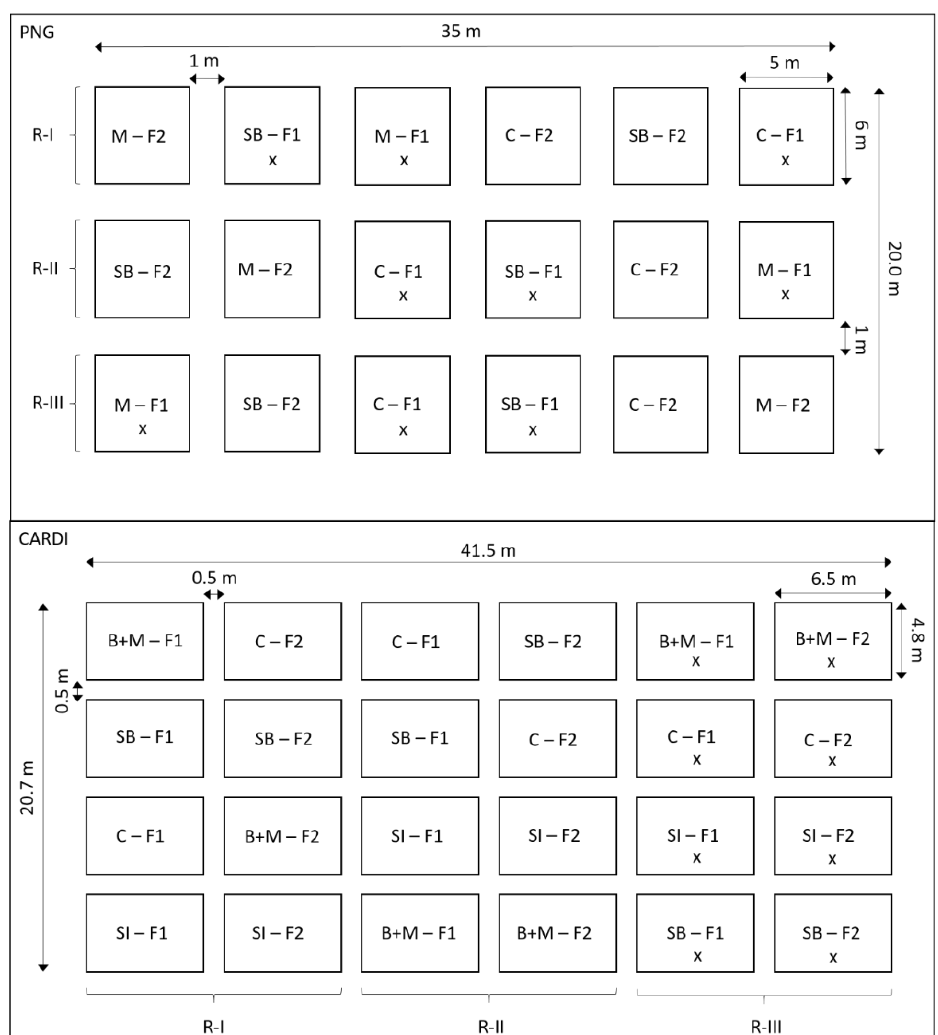
Figure 2. Experimental layout during the 2016/17 dry season of experiment 1 at PNG ( top ) and experiment 2 at CARDI ( bottom ). Location of the soil water tension sensors in each experiment is indicated with the symbol “x”. C = control; SB = rice straw buried; M = manure; B + M = biochar plus manure; SI = rice straw incorporated. F1 and F2 in the experiment at PNG indicate fertilizer placed in the middle of the bed and along the edge of the bed, respectively. At CARDI, F2 plots were fertilized with 1.5 times the rate applied in F1